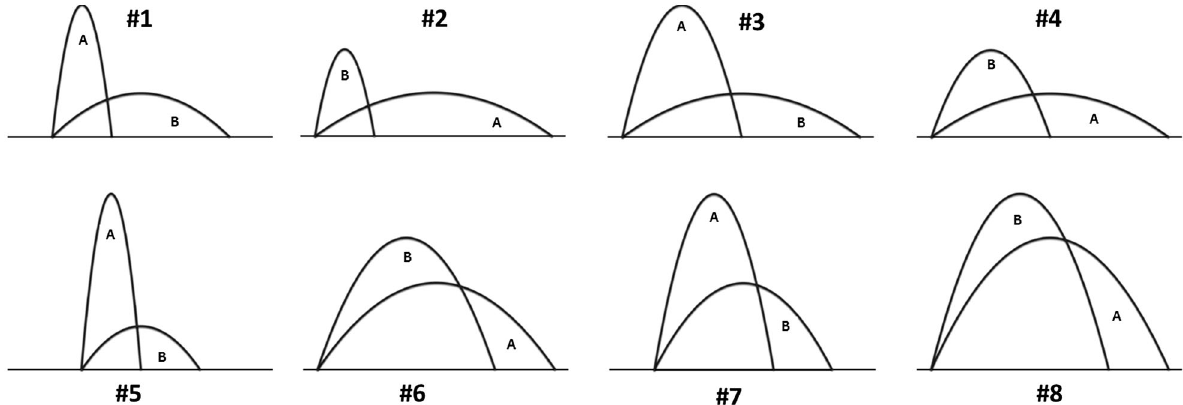
FIG. 11. The eight projectile pairs used for the linked true or false problem described in the text. The figures were adapted from Ref. [13].